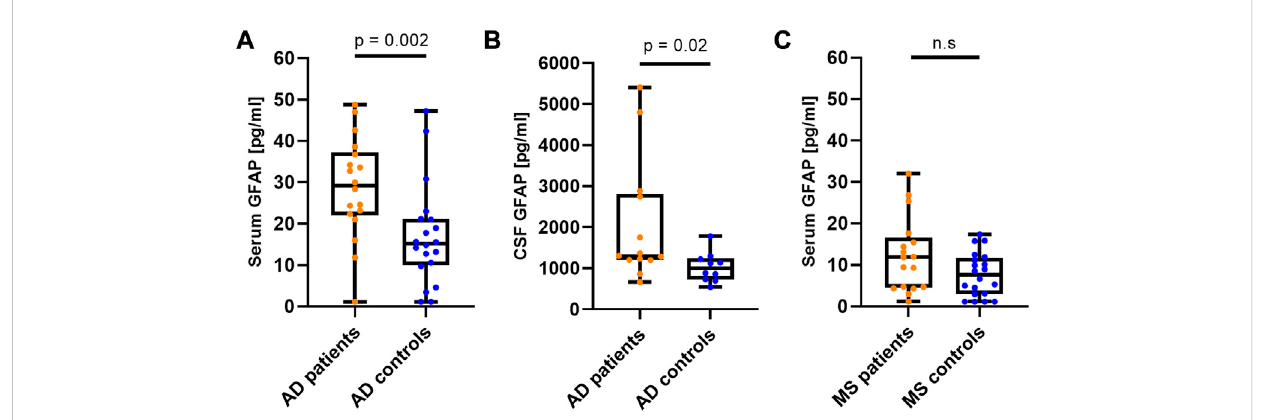
signi fi cantly correlated with related Simoa values ( r = 0.88 (95% CI: 0.81 – 0.93), p < 0.0001).